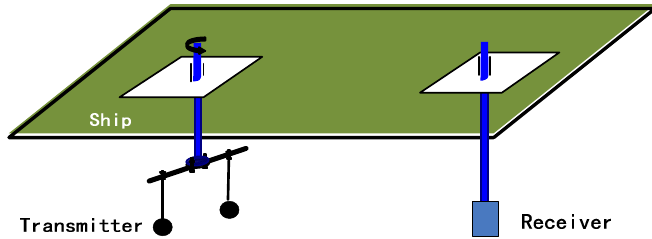
Figure 15. Configuration of the synthetic echo test.